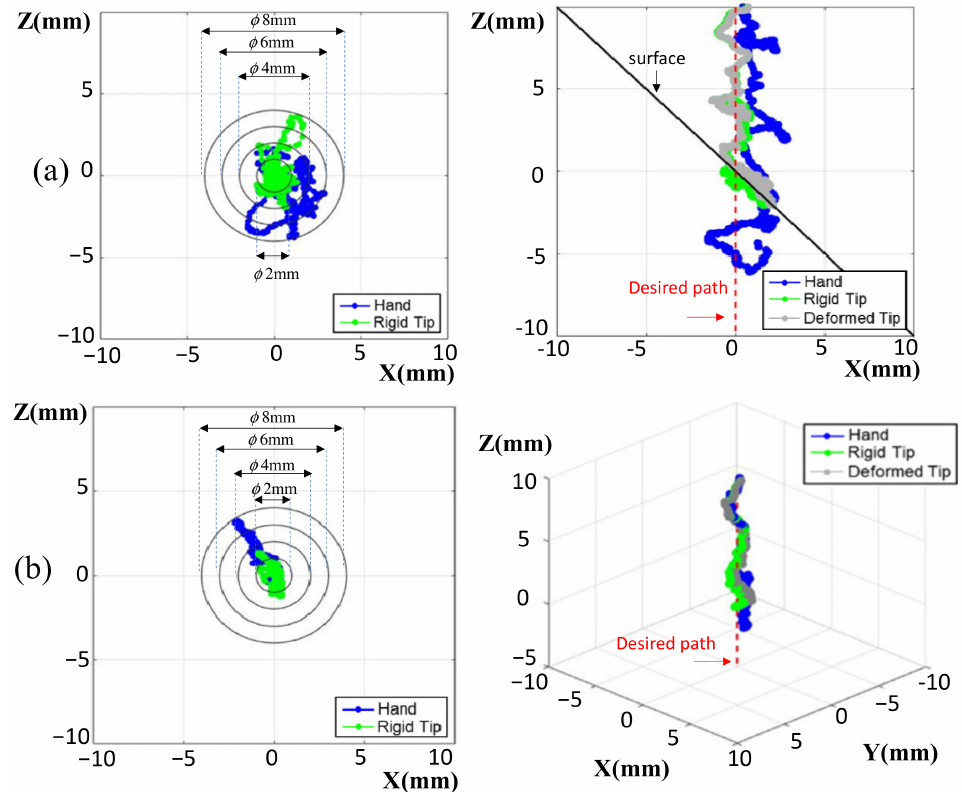
Figure 9. Tool trajectories upon approach to the target entry point with contact compliance adjustment: ( a ) on the ASTM test jig; ( b ) on the vertebra surface with varying